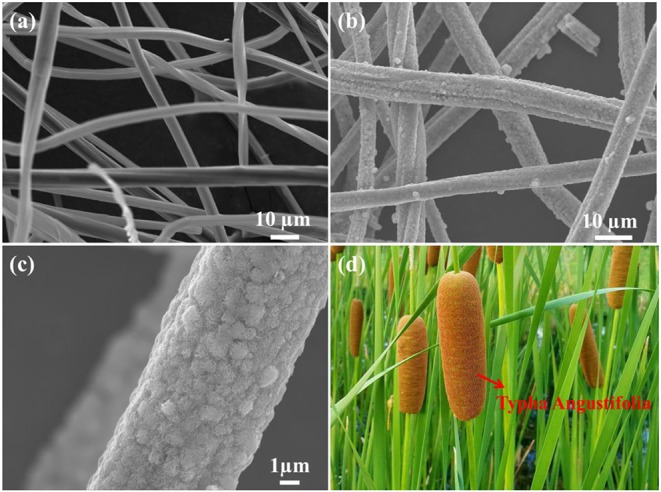
SEM images of (a) bamboo carbon fiber, (b,c) BCF/MoS2, and (d) the digital photo of Typha Angustifolia.